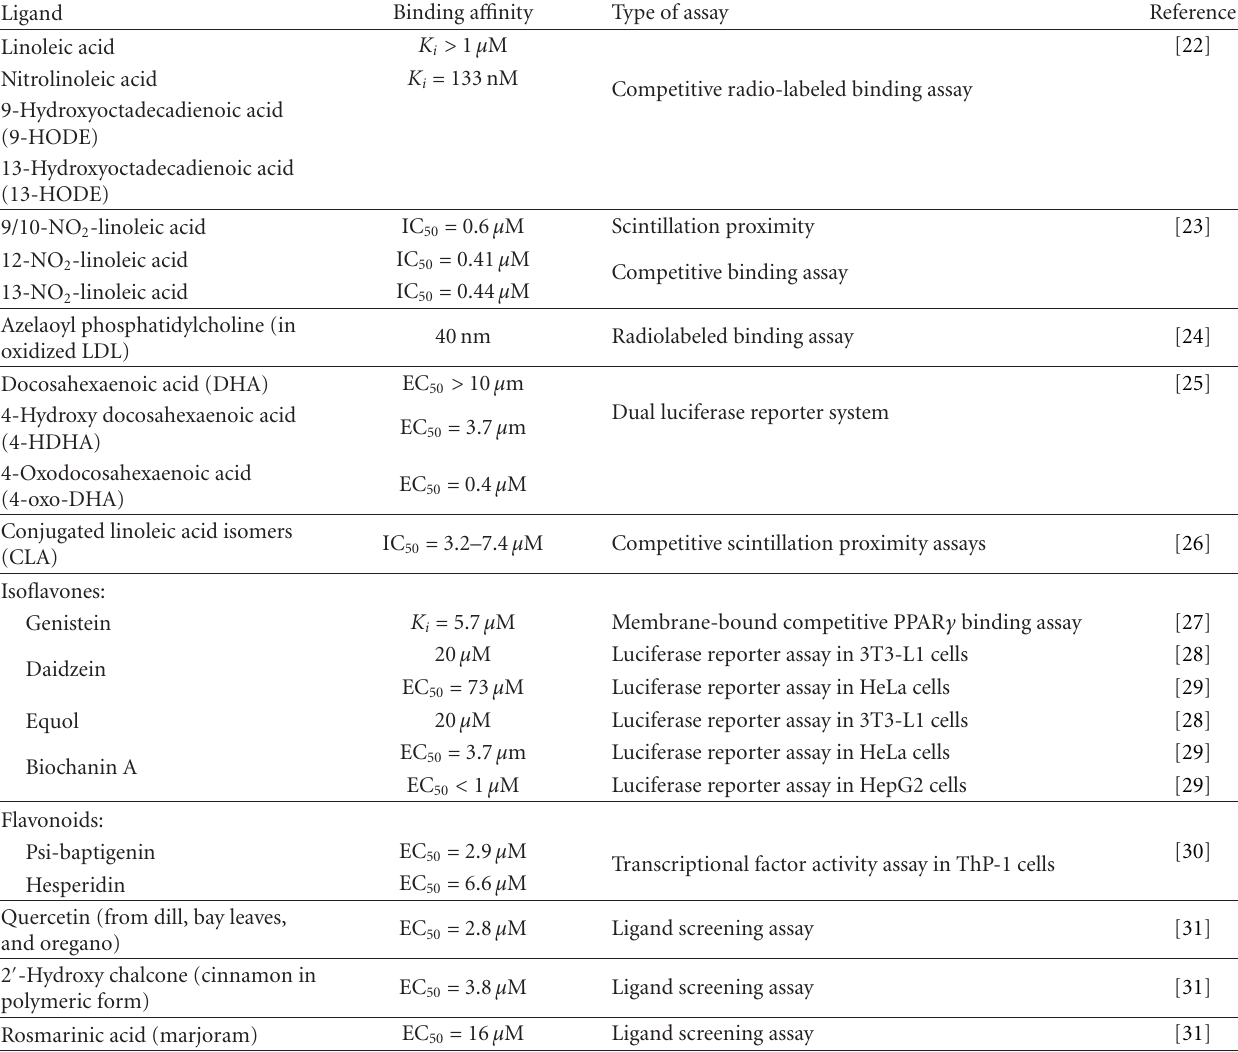
Table 1: Potential dietary PPAR γ